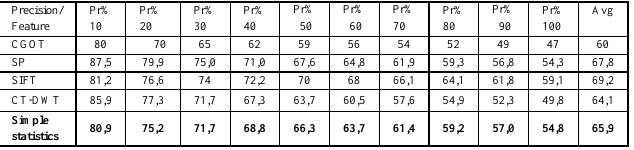
Table 4. Comparison with other methods using average precision values for each category.